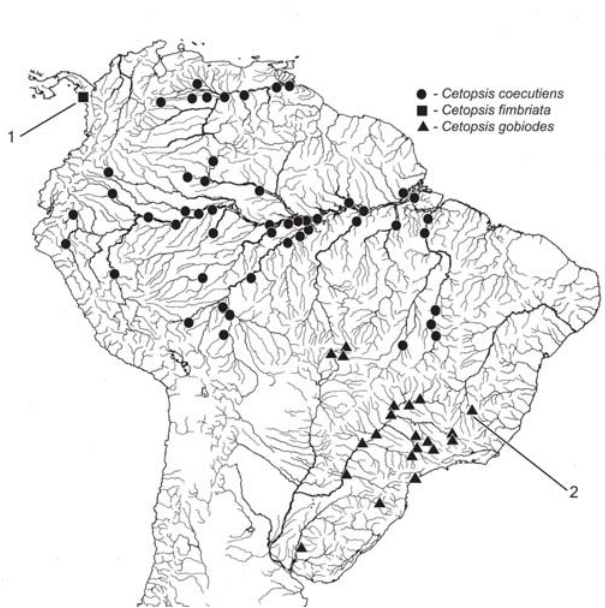
Fig. 19. Map of central and northern South America showing geographic distribution of Cetopsis coecutiens (type locality inexact = Brazil), Cetopsis fimbriata (1 = holotype locality), and Cetopsis gobioides (2 = lectotype locality of Cetopsis chalmersi ) (some symbols represent more that one locality and/or lot of